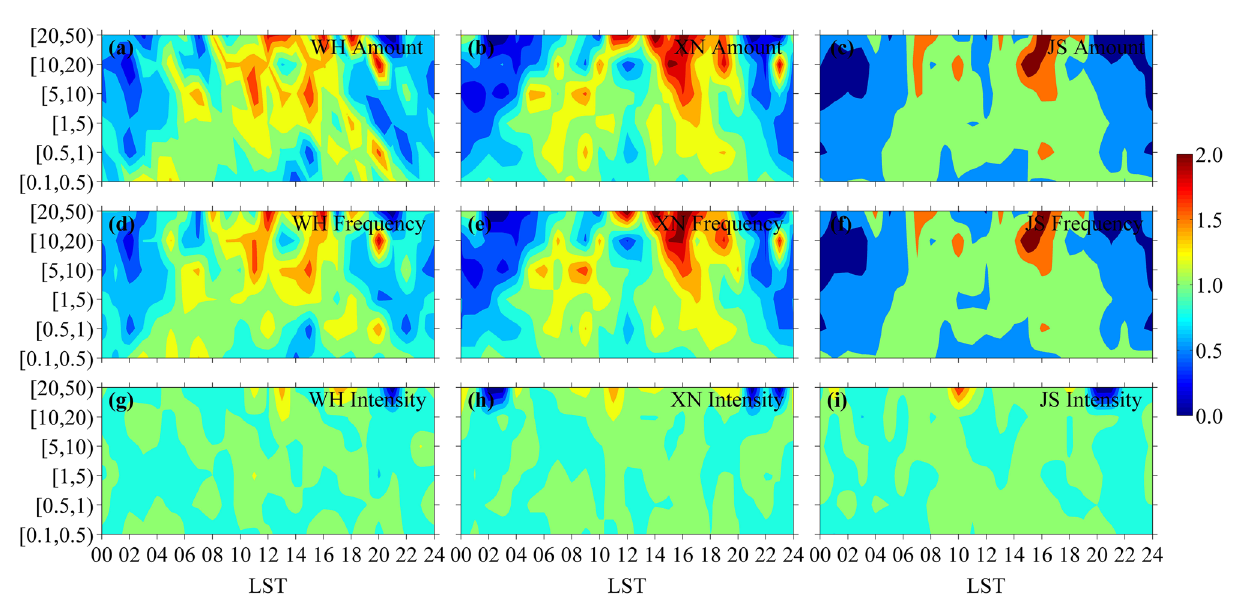
Figure 5. Diurnal variations of precipitation ( a – c ) amount, ( d – f ) frequency and ( g – i ) intensity with dimensionless processing obtained from summer hourly precipitation data of WH (left), XN (middle) and JS (right) stations during